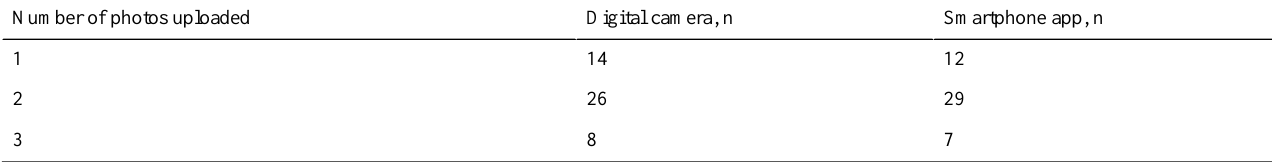
Table 3. Subgroup categories separated by number of photos uploaded.